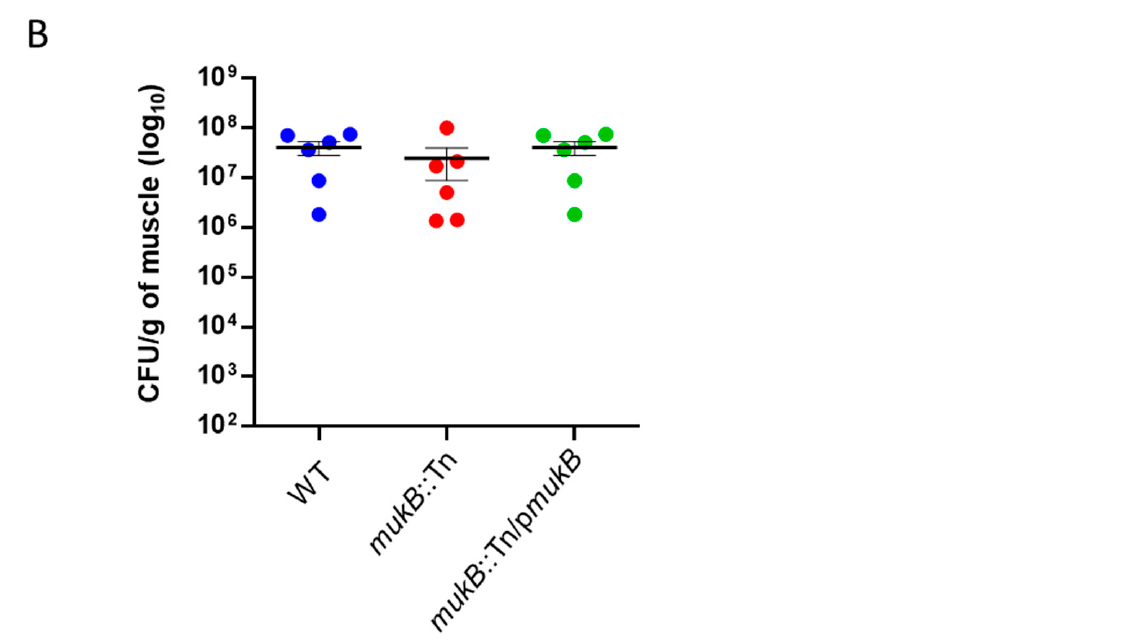
Figure 4. MukB mutation does not affect the proliferation of V. vulnificus at the local infection site. ( A ) Bacterial spread through the subcutaneous tissue. The luminescence signal of WT, E4 (nonencapsulated strain), mukB ::Tn, and mukB ::Tn/p mukB was detected every 3 h by IVIS during the 12-h time course. ( B ) Burden of WT, mukB ::Tn, and mukB ::Tn/p mukB infections in the muscle beneath the subcutaneous inoculation site. The degree of burden was assessed as CFU/g at 12 h post-infection. Each symbol represents an individual mouse ( n = 6/group). Error bars indicate standard error of mean (SEM). No significant difference among bacterial burdens in the three groups. CFU, Colony forming unit.